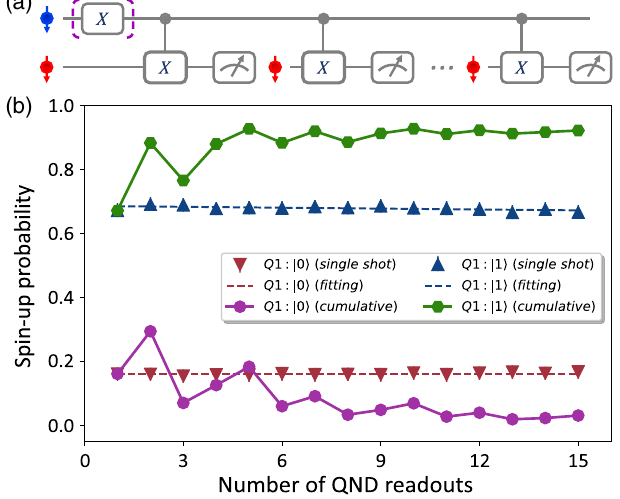
FIG. 2. (a) Circuit diagram for the repetitive QND readout scheme, using the same labels as in Fig. 1(c). (b) Spin-up probability obtained from individual QND readout cycles (tri- angles) and from a cumulative weighted majority vote (circles) for preparation of Q 1 in state j 1 i (blue) and in state j 0 i (red). For the individual readout cycles, the visibility does not improve and in fact slightly decreases due to the finite relaxation time T 1 of Q 1 . By fitting the measured P Q 1 in state j 1 i 1 for preparation of to an exponential, we estimate T 1 ¼ 1 . 8 (cid:1) 0 . 6 s. The cumulative weighted majority vote improves the logical readout visibility as more QND readout cycles are